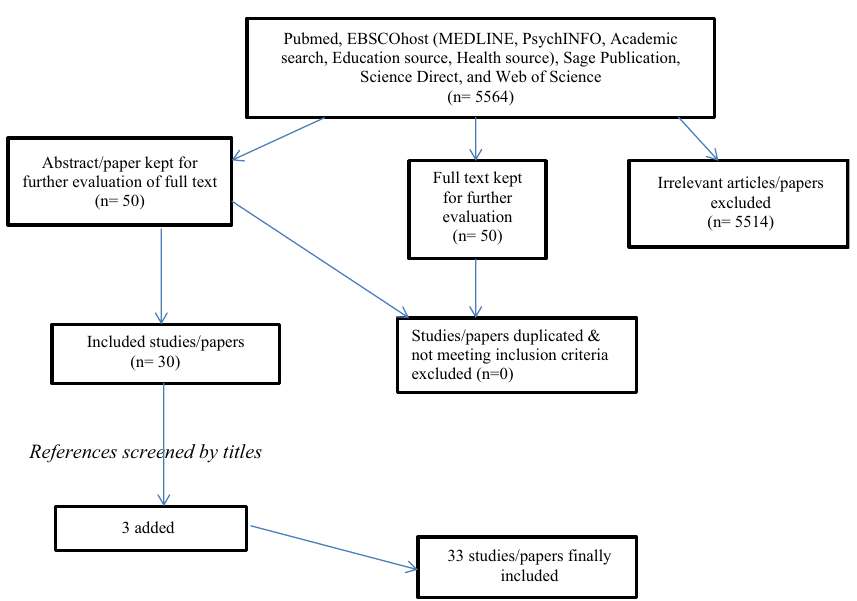
Figure 1. Flow chart for the selection of